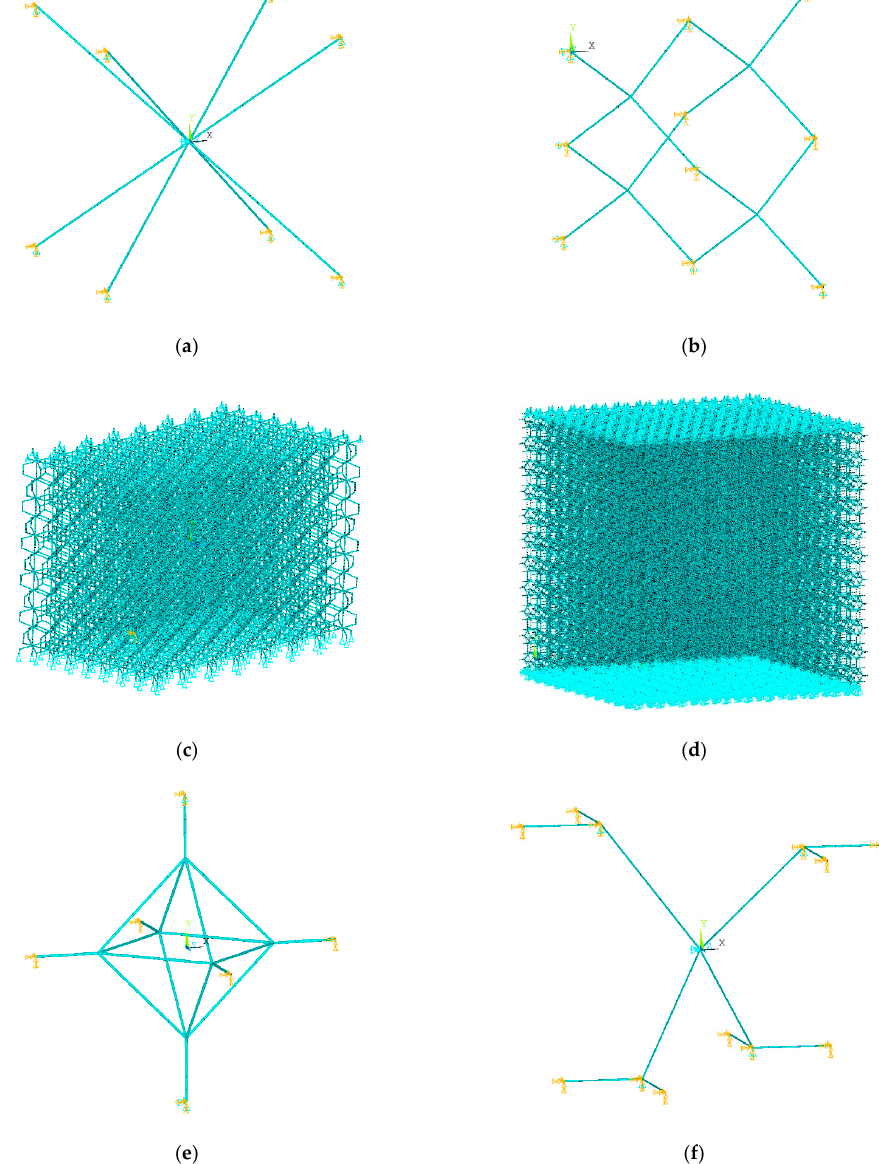
Figure A2. FE models and boundary conditions of unit cells: ( a ) BCC; ( b ) diamond; ( c ) hexagonal packing; ( d ) rhombicuboctahedron; ( e ) truncated cube, and ( f ) truncated octahedron in ANSYS APDL.